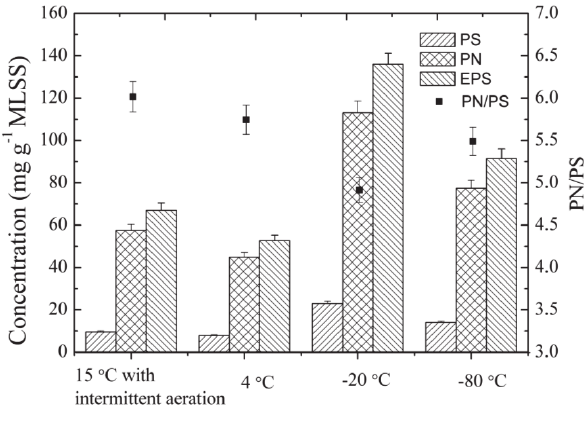
– EPSs, PN, and PS content and the ratio of protein/ polysaccharides (PN/PS) of the